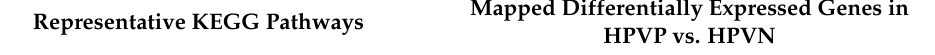
Table 1. Representative enriched KEGG pathways with some of the top enriched respective genes from the DEG pool.